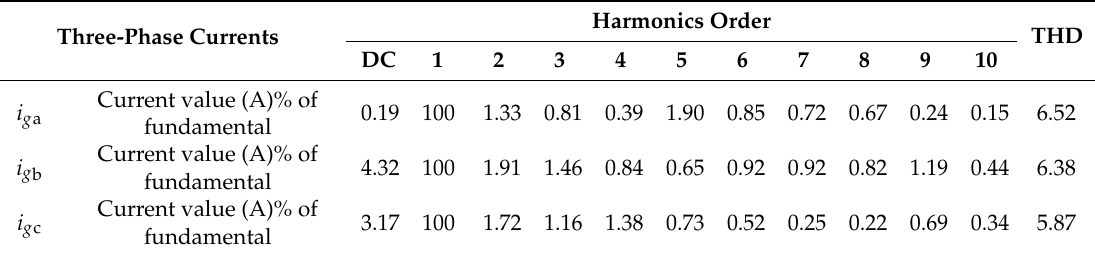
Table 4. Harmonics and THD of the three-phase currents with the dc component suppression. Three-Phase